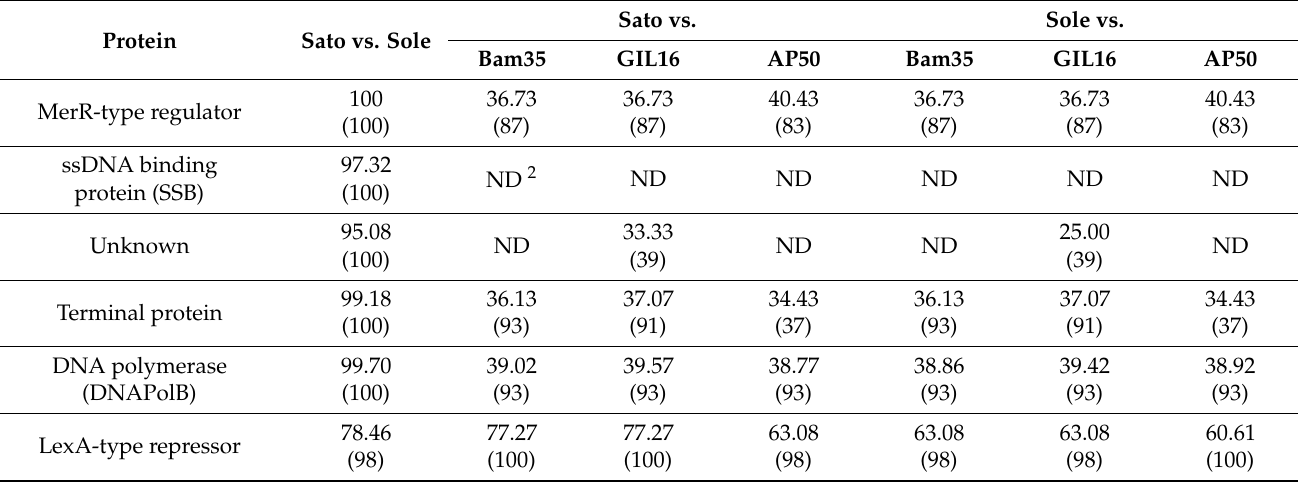
Table 2. Percentage of amino acid sequence identities of common proteins encoded in the gene regulation-genome replication module of Sato and Sole and other betatectiviruses 1 . Sato vs. Protein Sato vs. Sole